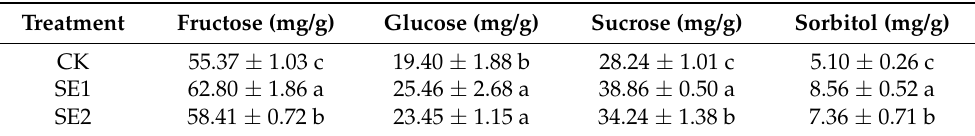
Table 4. Effects of bio-organic fertilizer on the contents of fructose, glucose, sucrose and sorbitol in ‘Fuji’ apples.